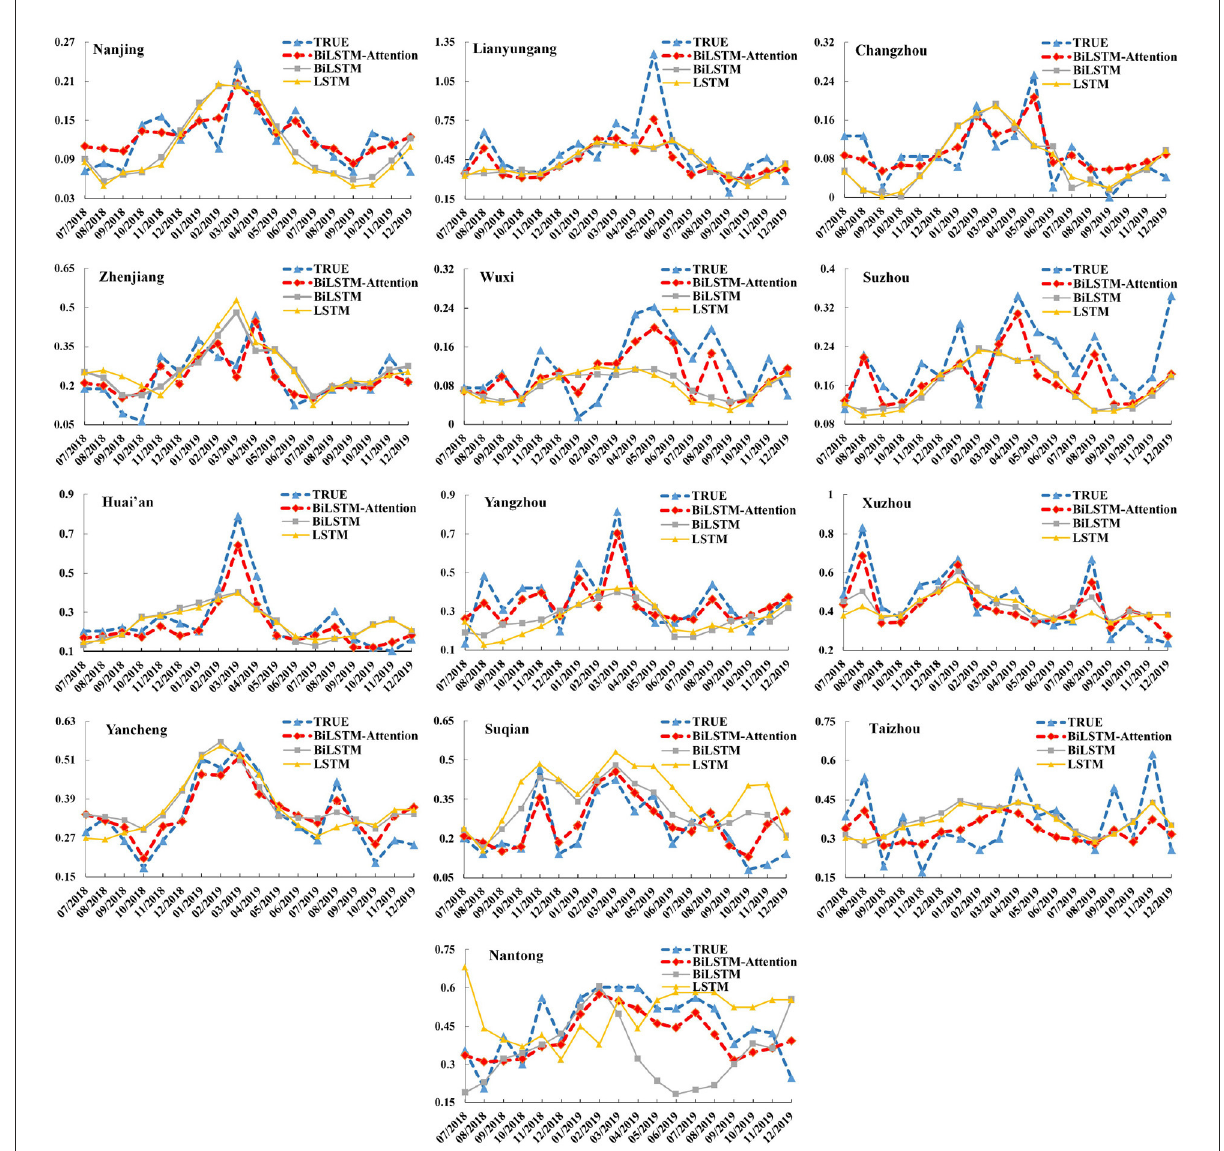
FIGURE4 The monthly incidence rates (including the true results and predicted ones of BiLSTM–Attention, BiLSTM, and LSTM) of hepatitis E for the 13 cities in Jiangsu Province (x-axis: month, y-axis: incidence rate).